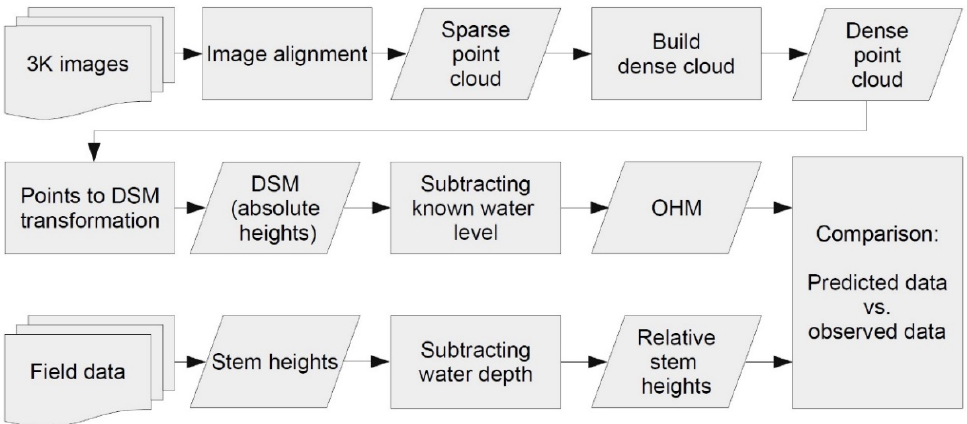
Figure 3. Flowchart of the photogrammetric processing chain and accuracy assessment for estimating reed stem heights.